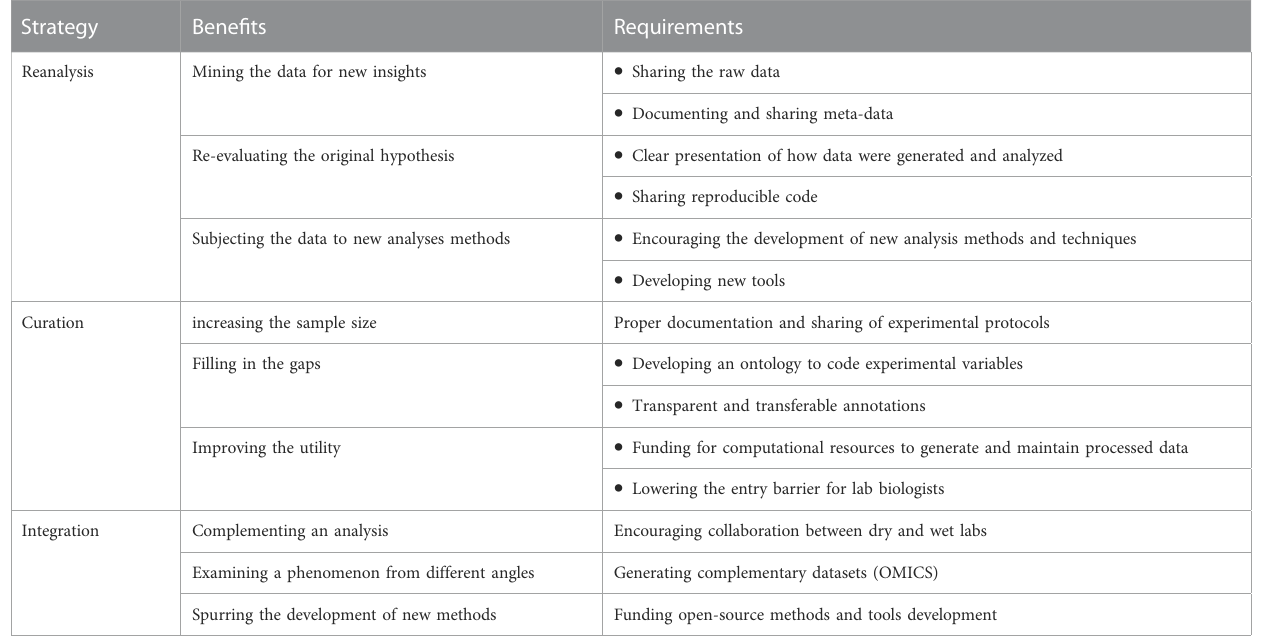
TABLE 1 Ways, bene fi ts, and requirements to increase the utility of public data.